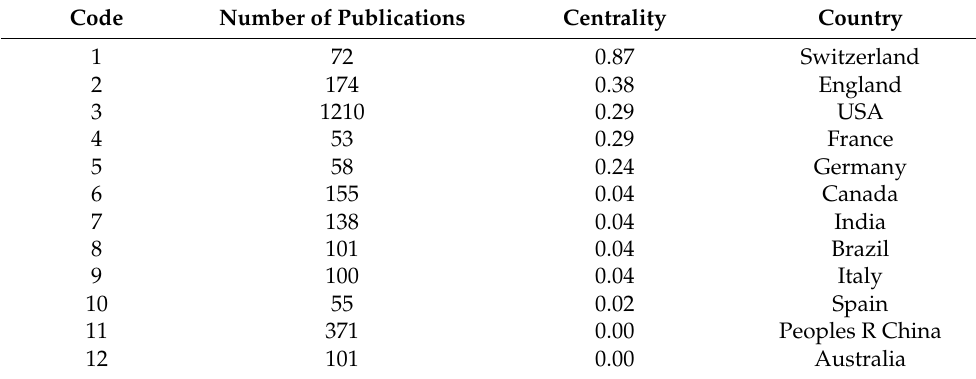
Table 3. The top 12 countries/regions in terms of publications (sorted by centrality). Code Number of Publications Centrality Country